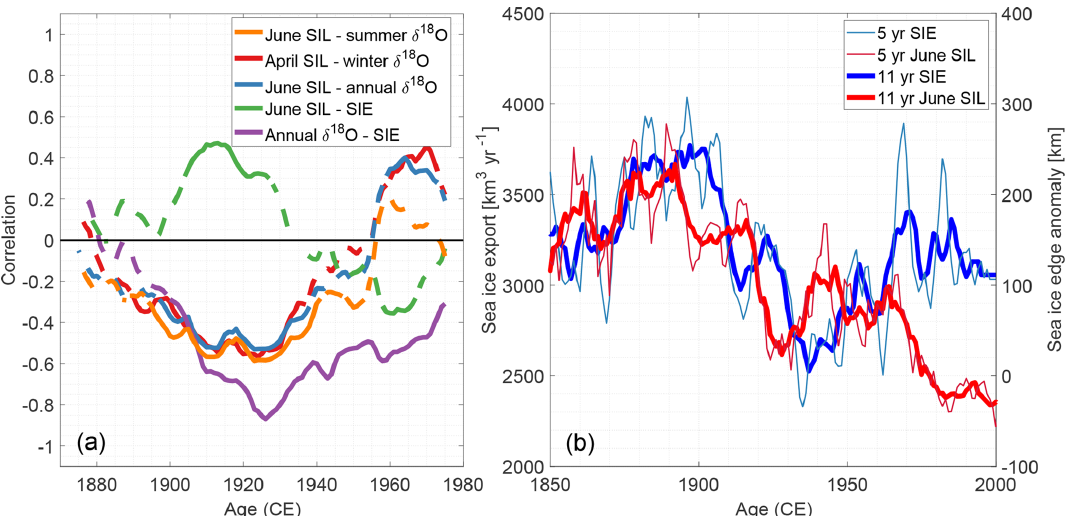
Figure 12. (a) Running correlations of 50 years between June SIL and summer δ 18 O (orange), April SIL and winter δ 18 O (red), June SIL and annual δ 18 O (blue), June SIL and Fram Strait SIE (green), and annual δ 18 O with Fram Strait SIE (purple). (b) Fram Strait SIE (blue) and Greenland Sea SIL (red) with 5- and 11-year moving means applied.